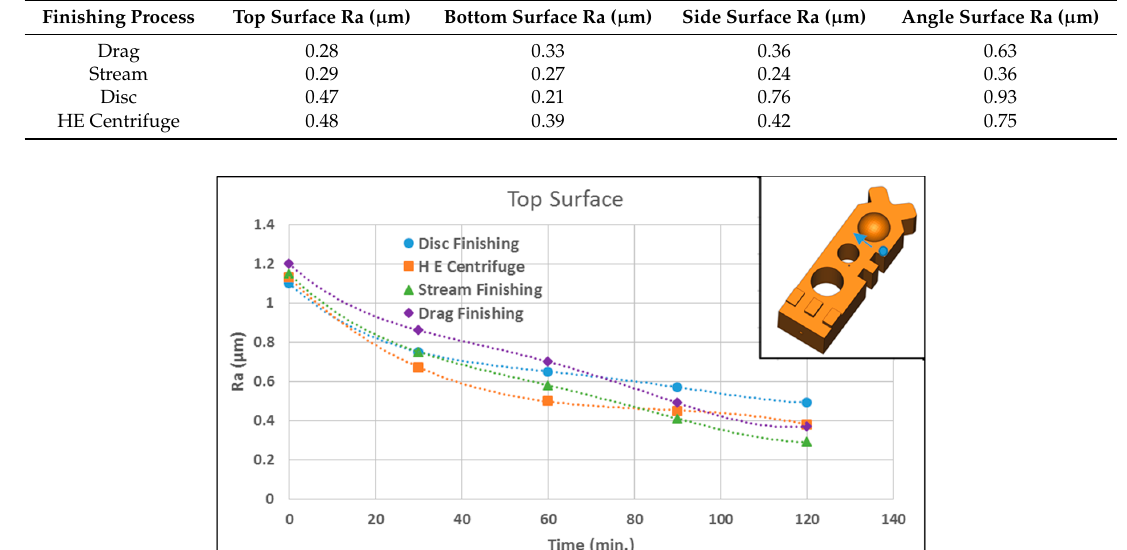
Table 4. Surface roughness values (average) of mass finishing processes at maximum processing time.